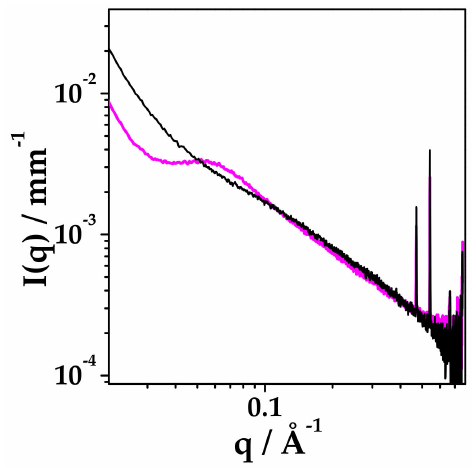
Figure 5. SAXS intensity profiles for HYA–DEX nanosuspension at 20 mg/mL dispersed in water (magenta) or phosphate buffer